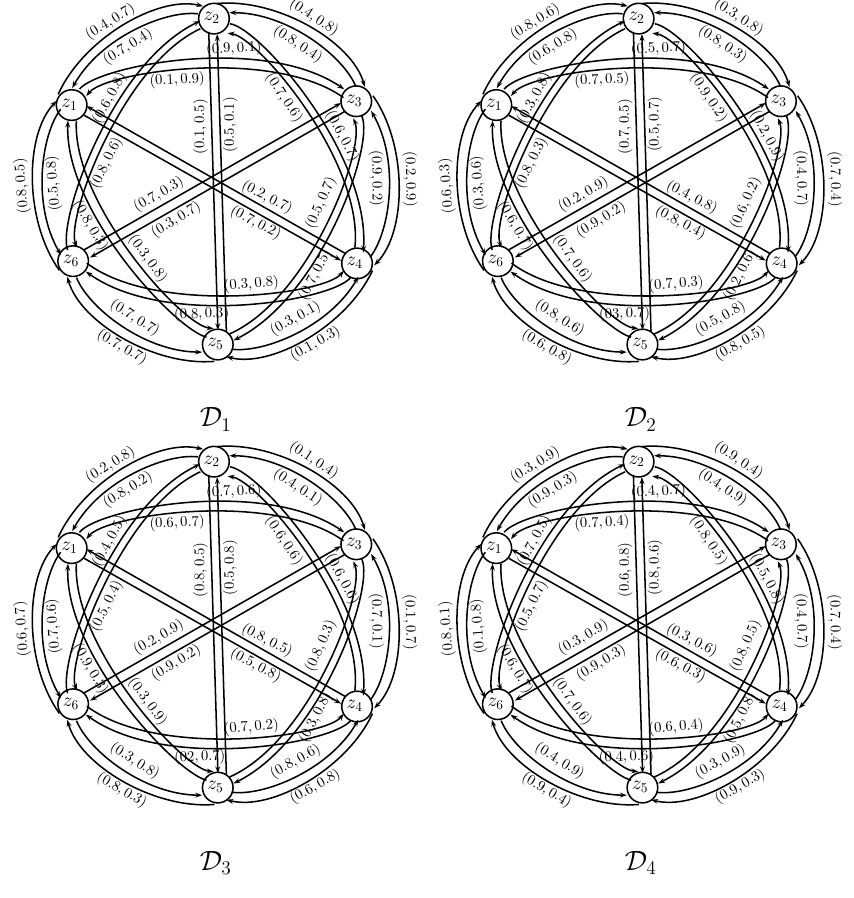
Table 4: PFPR of the third stock specialist. R 4